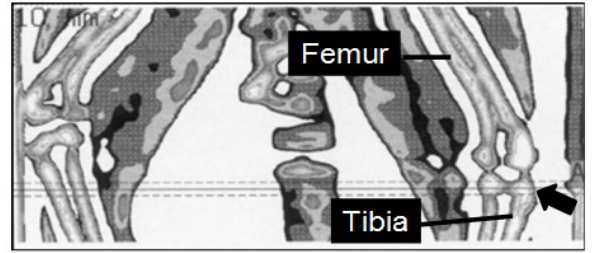
Figure 2. Tomographic scout view of the lower part of the body of a marmoset monkey showing bone tissue of the pelvic, lumbar, and sacral spine. The arrow points to the position of the reference line (solid line) which equals the center of the second-last lumbar verte- bral body. Rostral and caudal of this line, additional cross sections were taken at a distance of 1.0mm from the reference line (dashed lines). The image refers to a square of 2 . 8 × cm6cm.